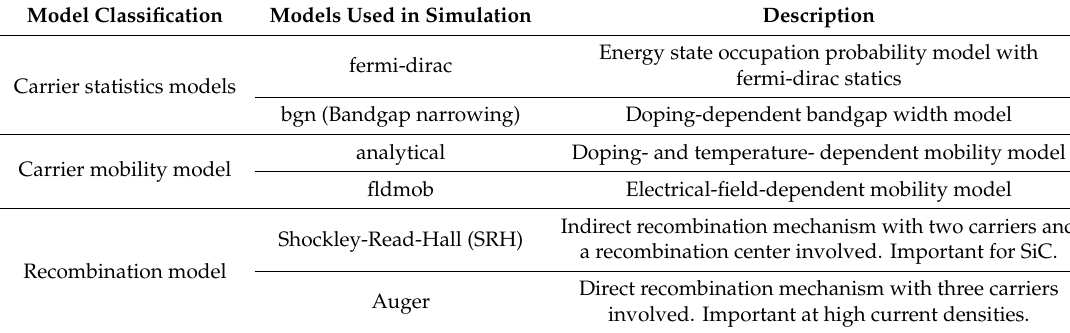
Figure 2. The simulation structures of the three devices. We define a ‘calculation cell’ and a ‘minimal cell’ for Device 1. The minimal cell is equivalent to the calculation cell for Device 2 and 3. Table 3. Physical models used for device forward characteristic simulation [36,37].